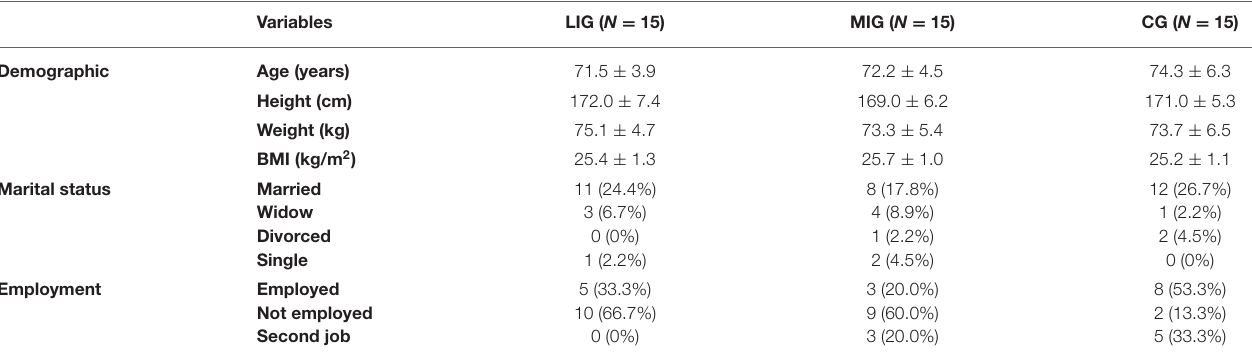
TABLE 1 | Participants characteristics, mean ± standard